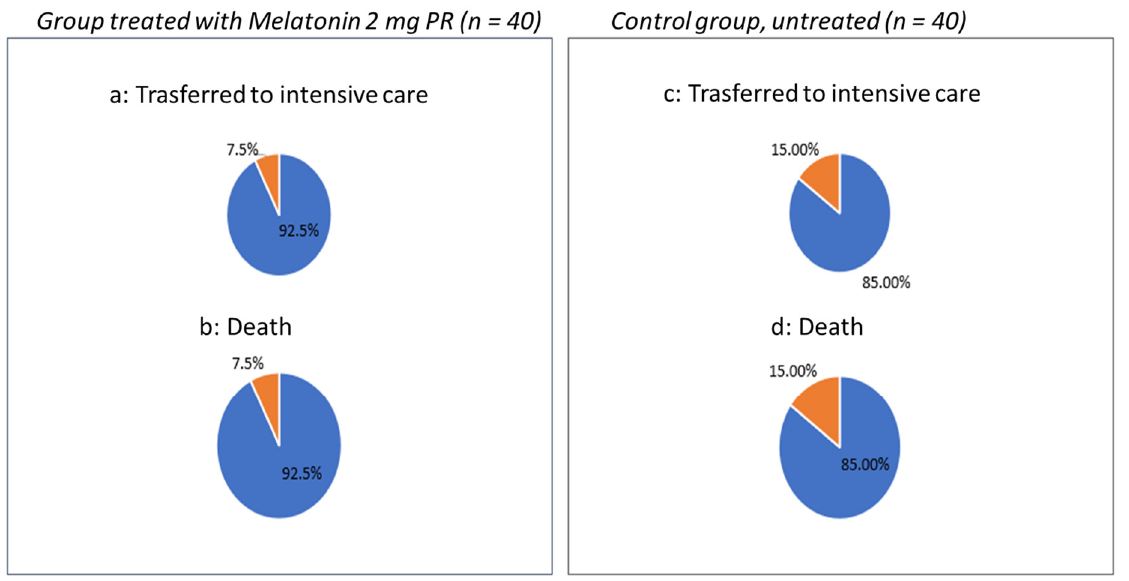
Figure 4. Number of patients transferred from sub-intensive to intensive care: in the group treated with PRM 2 mg, only 7.5% ( a ) versus 15% ( c ) of the un-treated group were transferred to intensive care due to clinical worsening, and 15% of the untreated group ( d ) died versus 7.5% of the treated group ( b ).